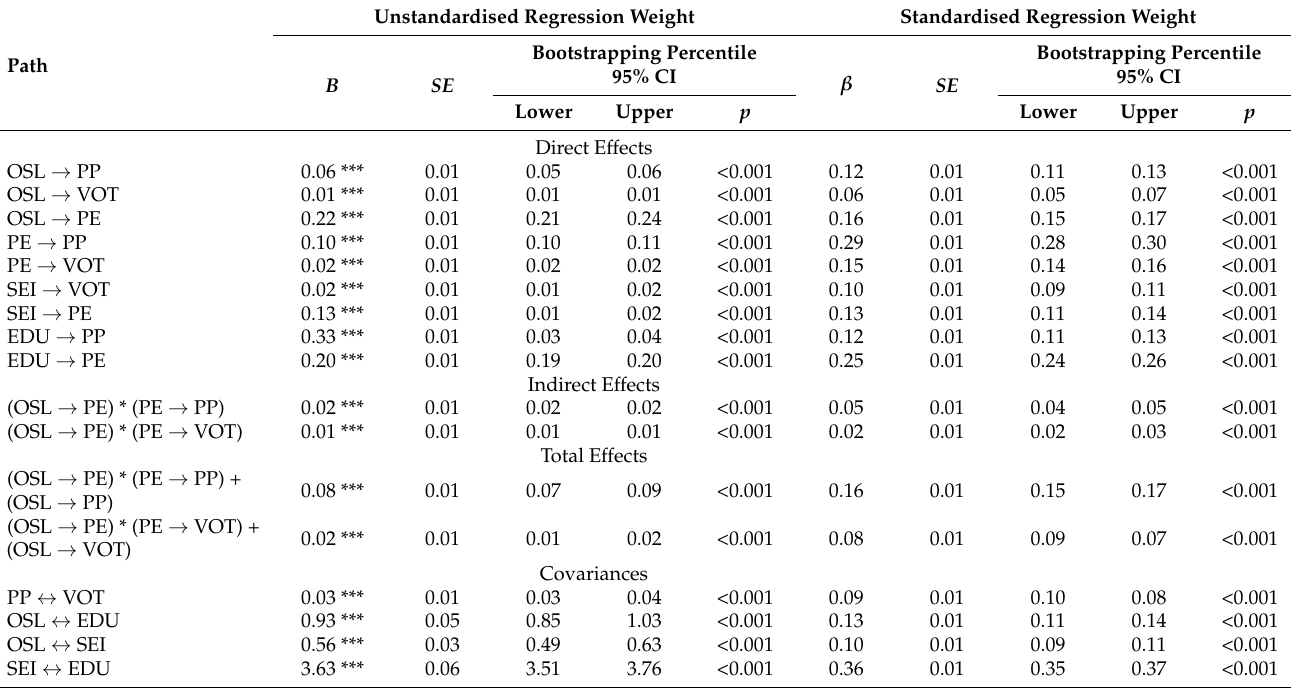
Table A5. Unstandardised and Standardised Direct, Indirect, and Total Effects and Covariances of the All Paths of the Hypothesised Model Done on the European Social Survey